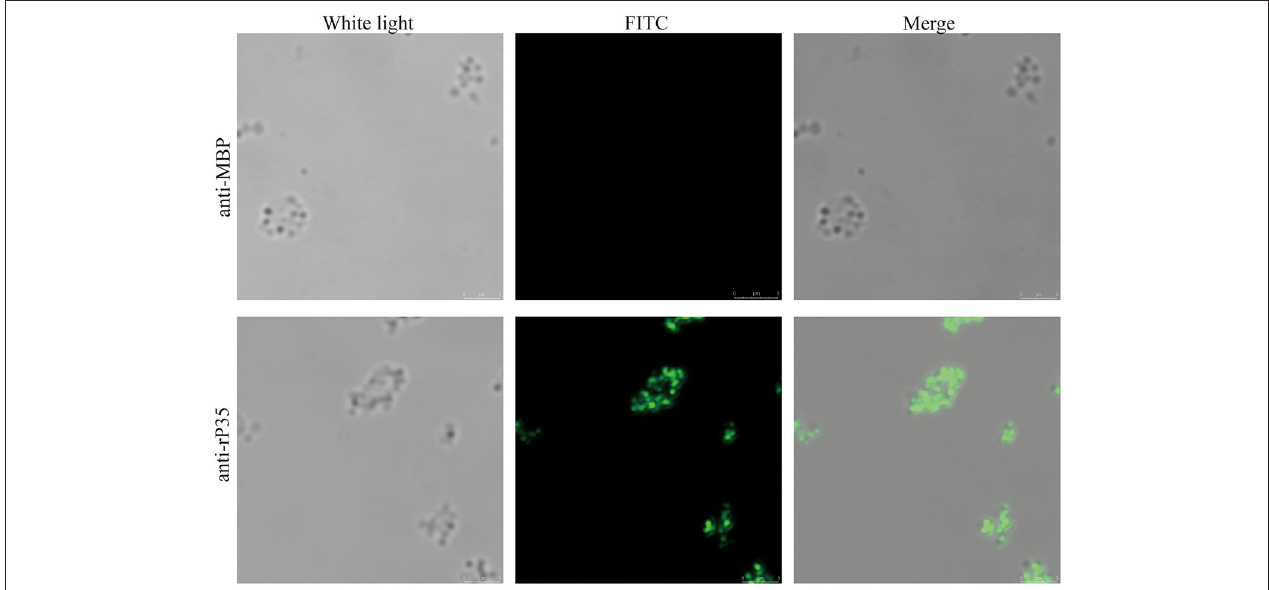
FIGURE 4 | Immunofluorescence assays of P35. After being washed twice, Mycoplasma synoviae (MS) cells were incubated with specific pathogen-free (SPF) chicken serum against rP35 and MBP without being permeated. Secondary antibody was fluorescein isothiocyanate (FITC)-conjugated goat anti-chicken IgG. Scale bars indicate 3 µ